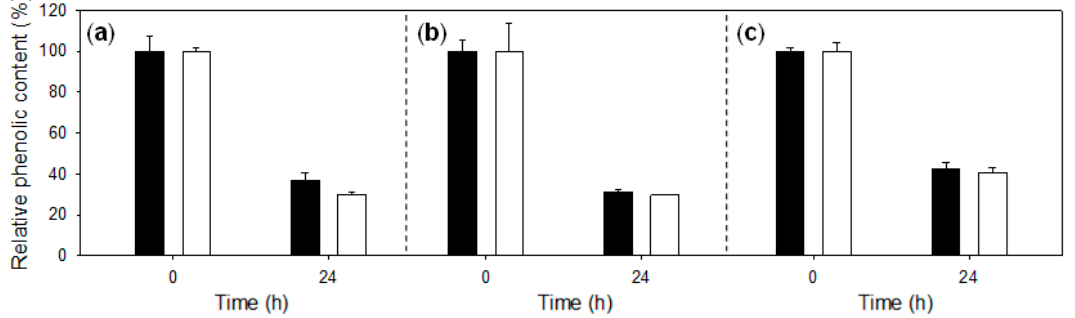
Figure 4. Variations in the relative phenolic content of lignosulfonate DP401 after treatment with LAC4 (black) and LAC1 (white) (25 mU/mL) for 24 h, without a mediator ( a ) or in the presence of violuric acid ( b ) or 4-hydroxybenzoic acid ( c ). Error bars indicate standard deviation for three replicas.